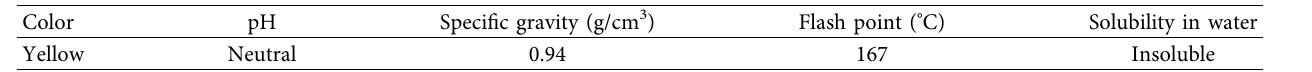
Table 8: The properties of PAWMA used.